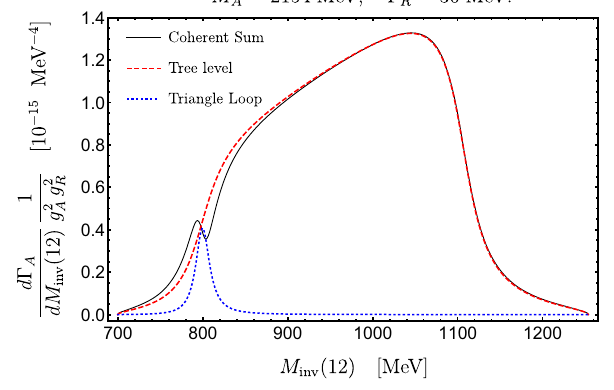
1 Fig. 13 d (cid:4) A as a function of M inv ( 12 ) with M A = dM inv ( 12 ) g 2 A g 2 R 2154 MeV and (cid:4) R = 30